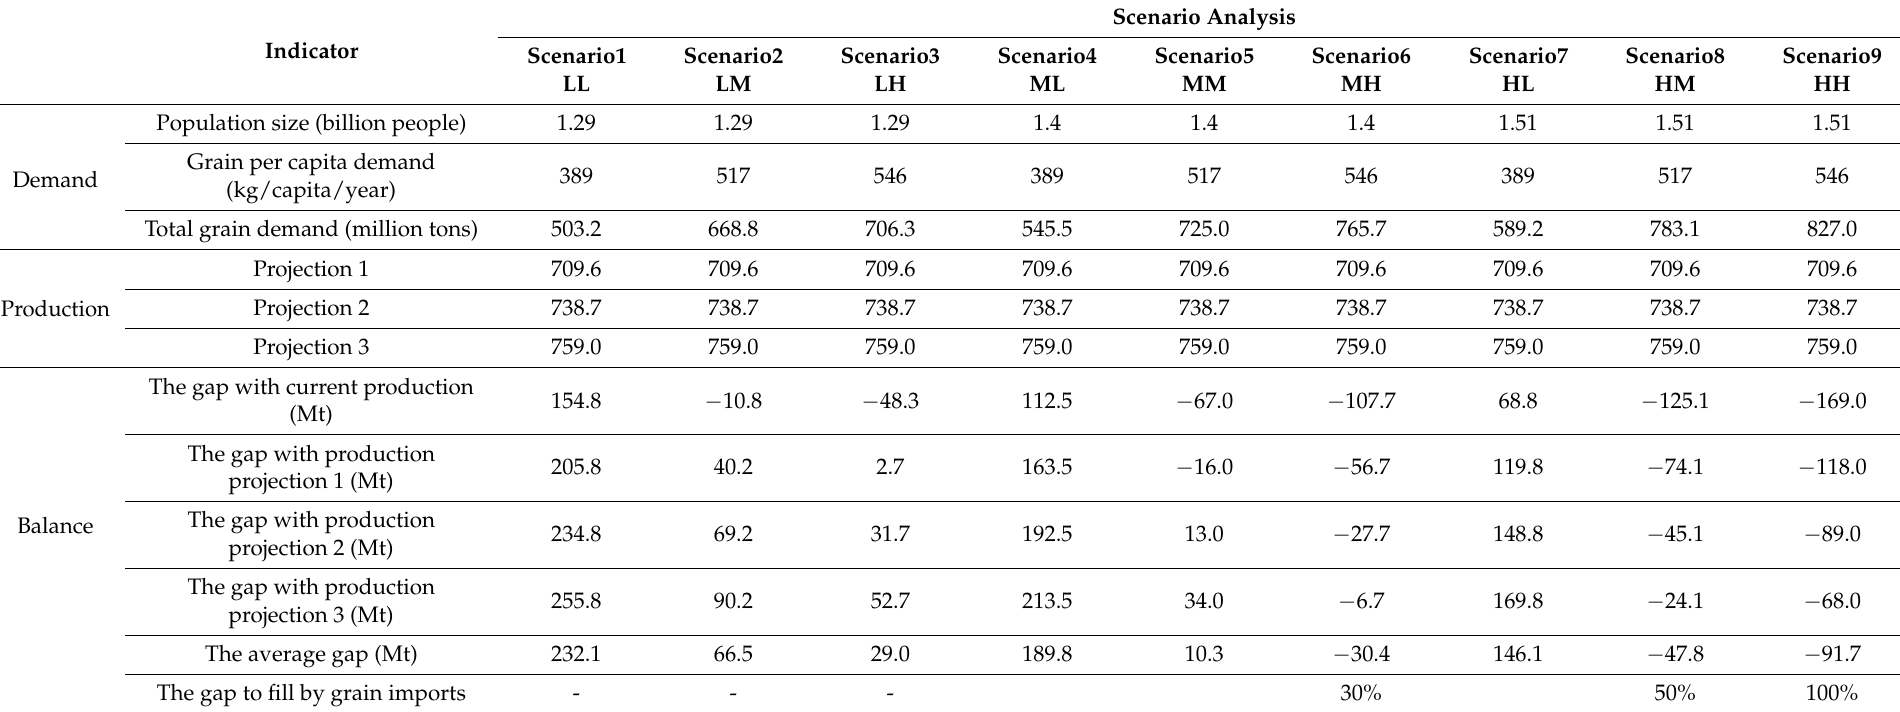
Table 2. 9 Scenario simulation values for grain demand and production in